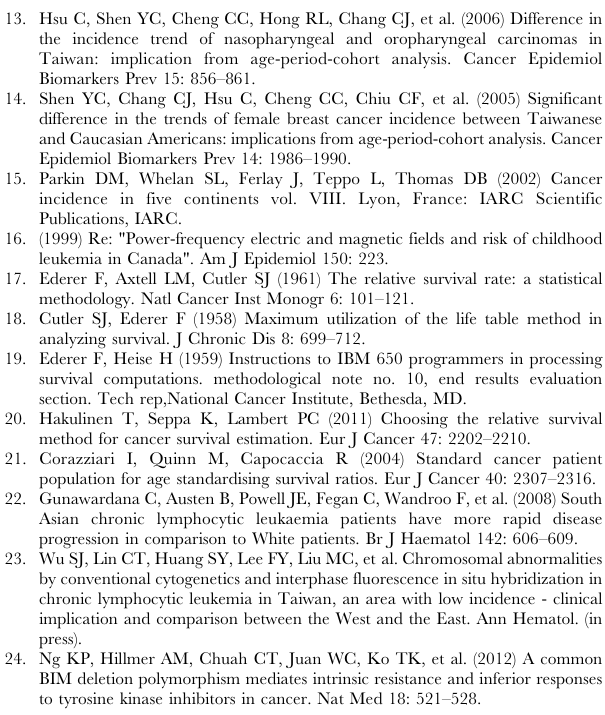
Figure S1 The annual trends of ASRS (A) and 5-year ASRS (B) of patients with CLL among Taiwanese, Caucasian Americans and Asian/Pacific